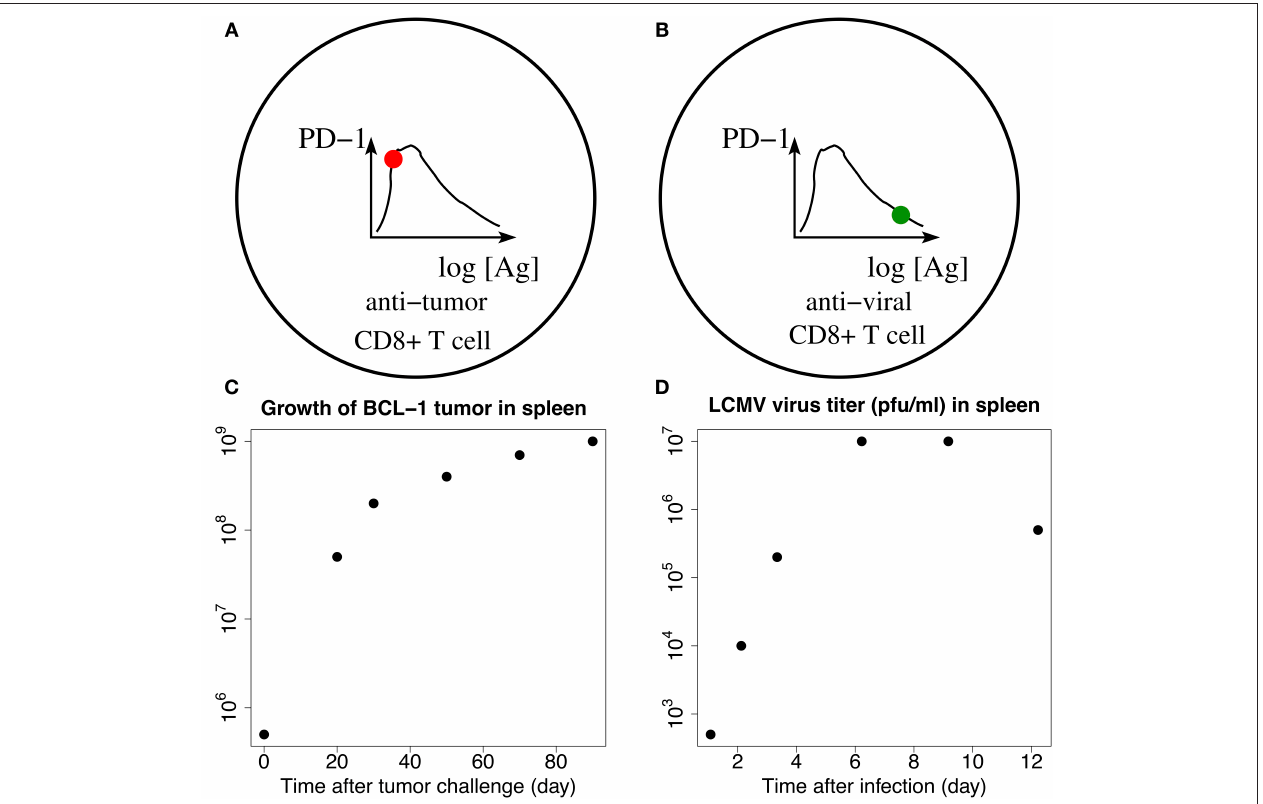
FIGURE 8 | Schematic illustration of the adaption loss/gain hypothesis. Solid filled circles on the corresponding graphs of PD-1 receptor levels (top panels), plotted vs. the log-concentrations of Ag, correspond to the levels of PD-1 receptors on anti-melanoma (A) and anti-virus (B) CD8+ T cells, respectively (top panels). Phenotype (B) corresponds to a fully developed adaptation of the PD-1 expression with respect to the increasing levels of Ag, while phenotype (A) is characterized by the lack of such adaptation. Bottom (C,D) show time-dependent levels of BCL-1 tumor cells (left) and LCMV virus titers (right) in the spleen. The data points are digitized from the corresponding plots in Kuznetsov et al. ( 91) and Bocharov et al. (92), respectively. Comparing (C,D) , we observe that the changes in the tumor Ag levels within the first 7 days are small, corresponding to the fold change less than 10 as seen from (C) . At the same time, the viral Ag levels change significantly, corresponding to the 10 4 -fold increase during the first seven days as seen from (D) . The small 7-day tumor Ag-level increase shown in (C) corresponds to the red solid “snapshot” circle in (A) , while the large 7-day increase in the viral Ag level shown in (D) corresponds to the green solid “snapshot” circle in (B) . Additional detailed explanations of (A–D) are provided in the main